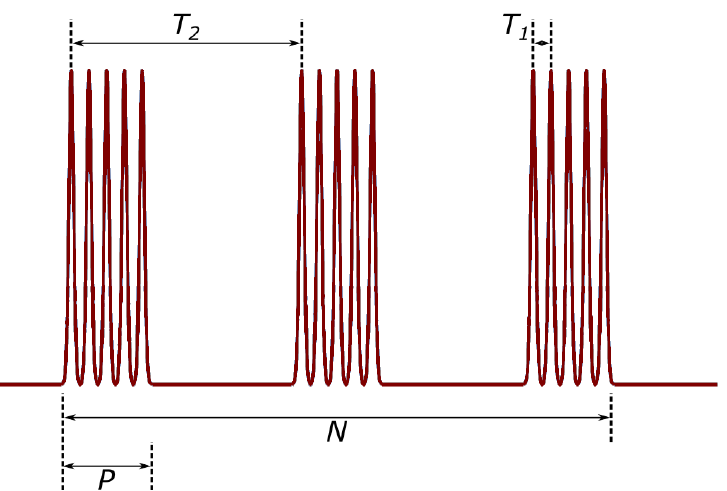
Figure 2. Schematic of burst principle. A single pulse is divided into a number of sub-pulses ( P ) and a number of burst packets (N ). This whole packet, consisting of burst packets is repeated at a laser repetition rate. T 1 and T 2 indicate intra-burst time. For the laser used in the experimental setup, P range is from 1 to 25, N range— from 1 to 9. When P = 1 and N is changed, we say the laser is in an MHz burst regime. On the contrary, when N = 1 and P is changed, the laser is in the GHz burst regime. When P and N are changed, the laser is in the bi-burst